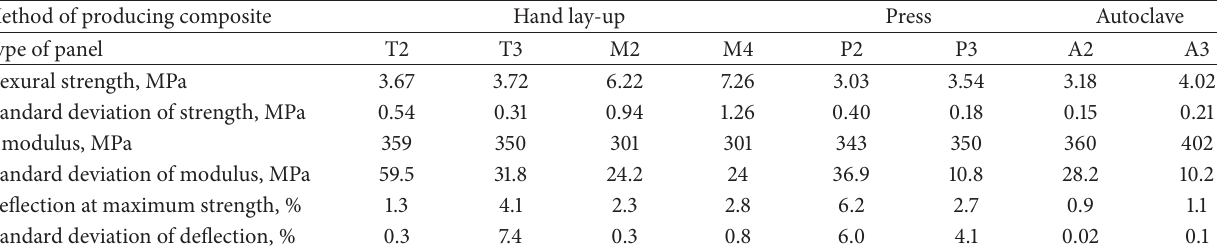
Table 4: Measurement results of properties at flexural